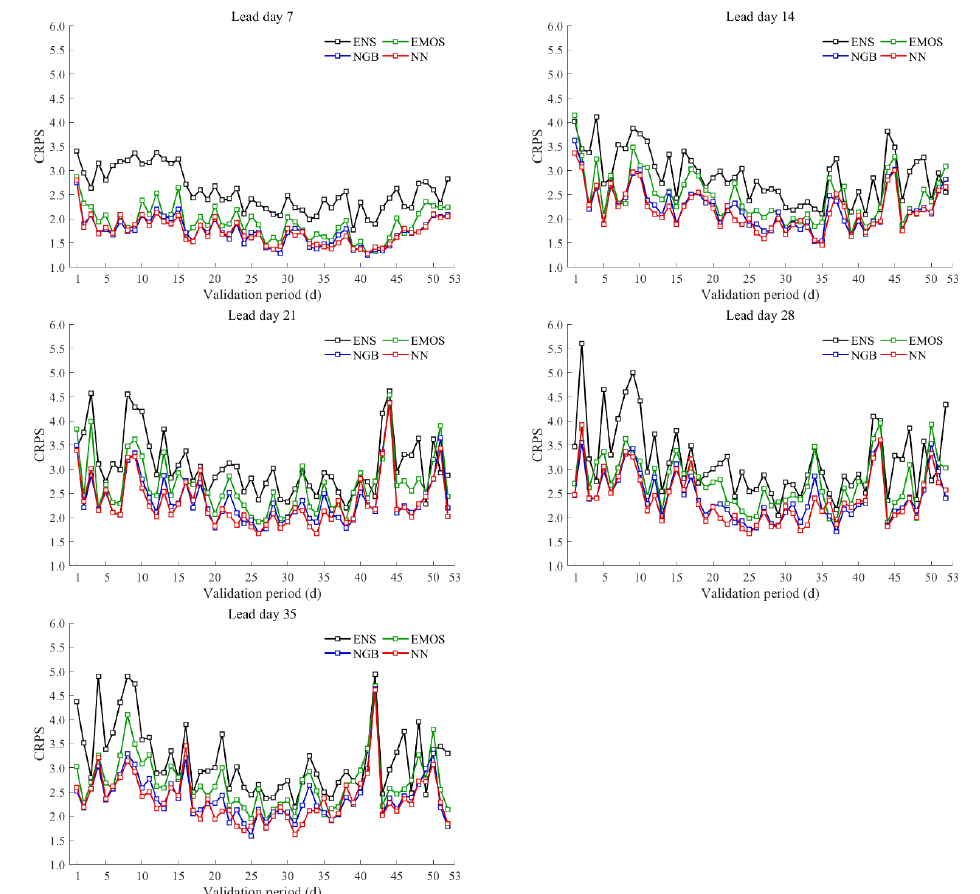
Figure 6. Mean continuous ranked probability skill score of the 2-m maximum air temperature probabilistic forecasts for all land grid points over East Asia on each calendar day during the validation period for the raw ensemble and using different post-processing methods at different lead times. CRPS, continuous ranked probability score; ENS, raw ensemble; EMOS, ensemble model output statistics; NGB, natural gradient boosting; NN, neural networks.